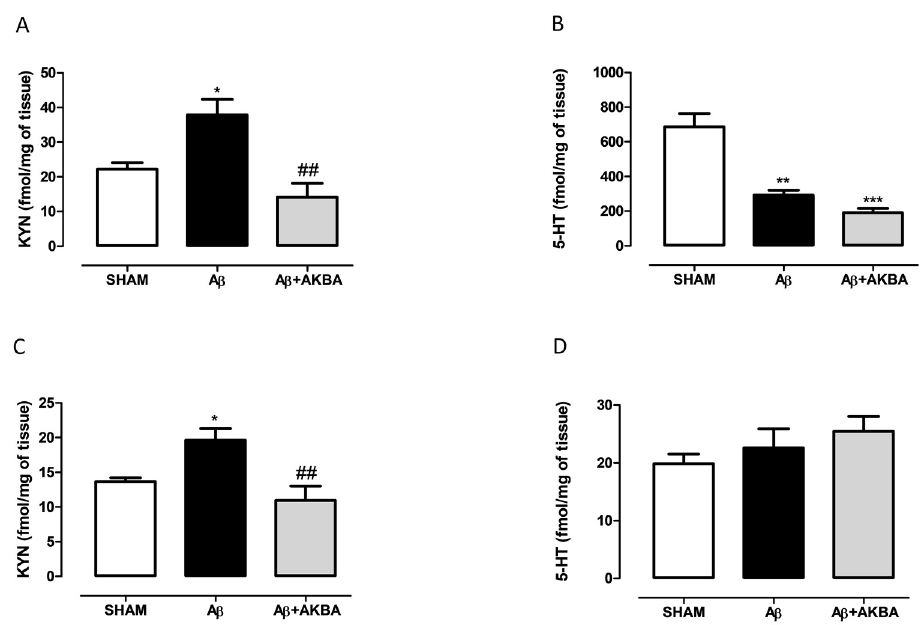
Figure 5. Effects of AKBA administration on KYN and 5-HT content in PFC and HIPP of A β -treated mice. ( A ) KYN (fmol/mg of tissue, SHAM n = 4, A β n = 5, A β +AKBA n = 5) and ( B ) 5-HT (fmol/mg of tissue, SHAM n = 7, A β n = 4, A β +AKBA n = 6) levels in the PFC of mice 7 days after icv injection of vehicle (SHAM, 5 µ L, white bar), A β (A β , 4 µ M, black bar), and A β +AKBA (A β , 4 µ M + sublingual AKBA, 5 mg/kg, gray bar). ( C ) KYN (fmol/mg of tissue, SHAM n = 6, A β n = 6, A β +AKBA n = 5) and ( D ) 5-HT (fmol/mg of tissue, SHAM n = 6, A β n = 6, A β +AKBA n = 6) levels in the HIPP of mice 7 days after icv injection of vehicle (SHAM, 5 µ L, white bar), A β (A β , 4 µ M, black bar), and A β +AKBA (A β , 4 µ M + sublingual AKBA, 5 mg/kg, gray bar). One-way ANOVA followed by Tukey’s multiple comparison test, * p < 0.0, ** p < 0.01 A β versus SHAM; *** p < 0.001 A β +AKBA versus SHAM; ## p < 0.01 A β +AKBA versus A β .